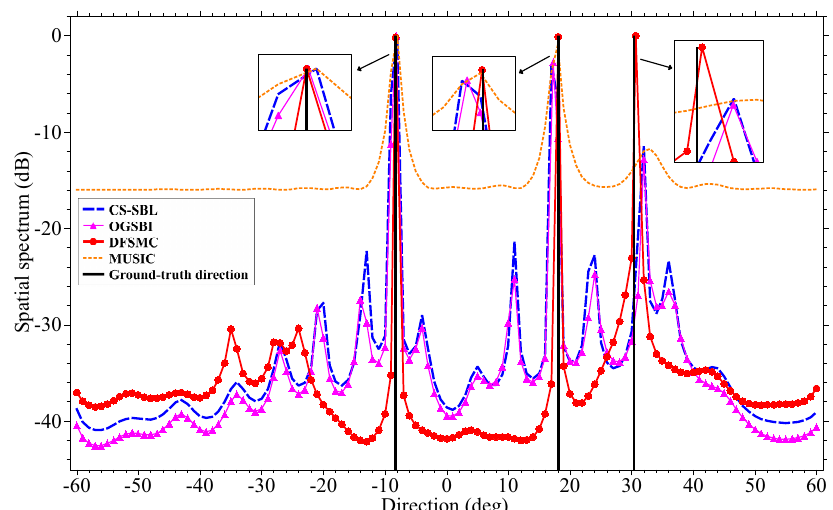
Figure 8. The spatial spectrum for direction estimation ( α c = − 5 dB).